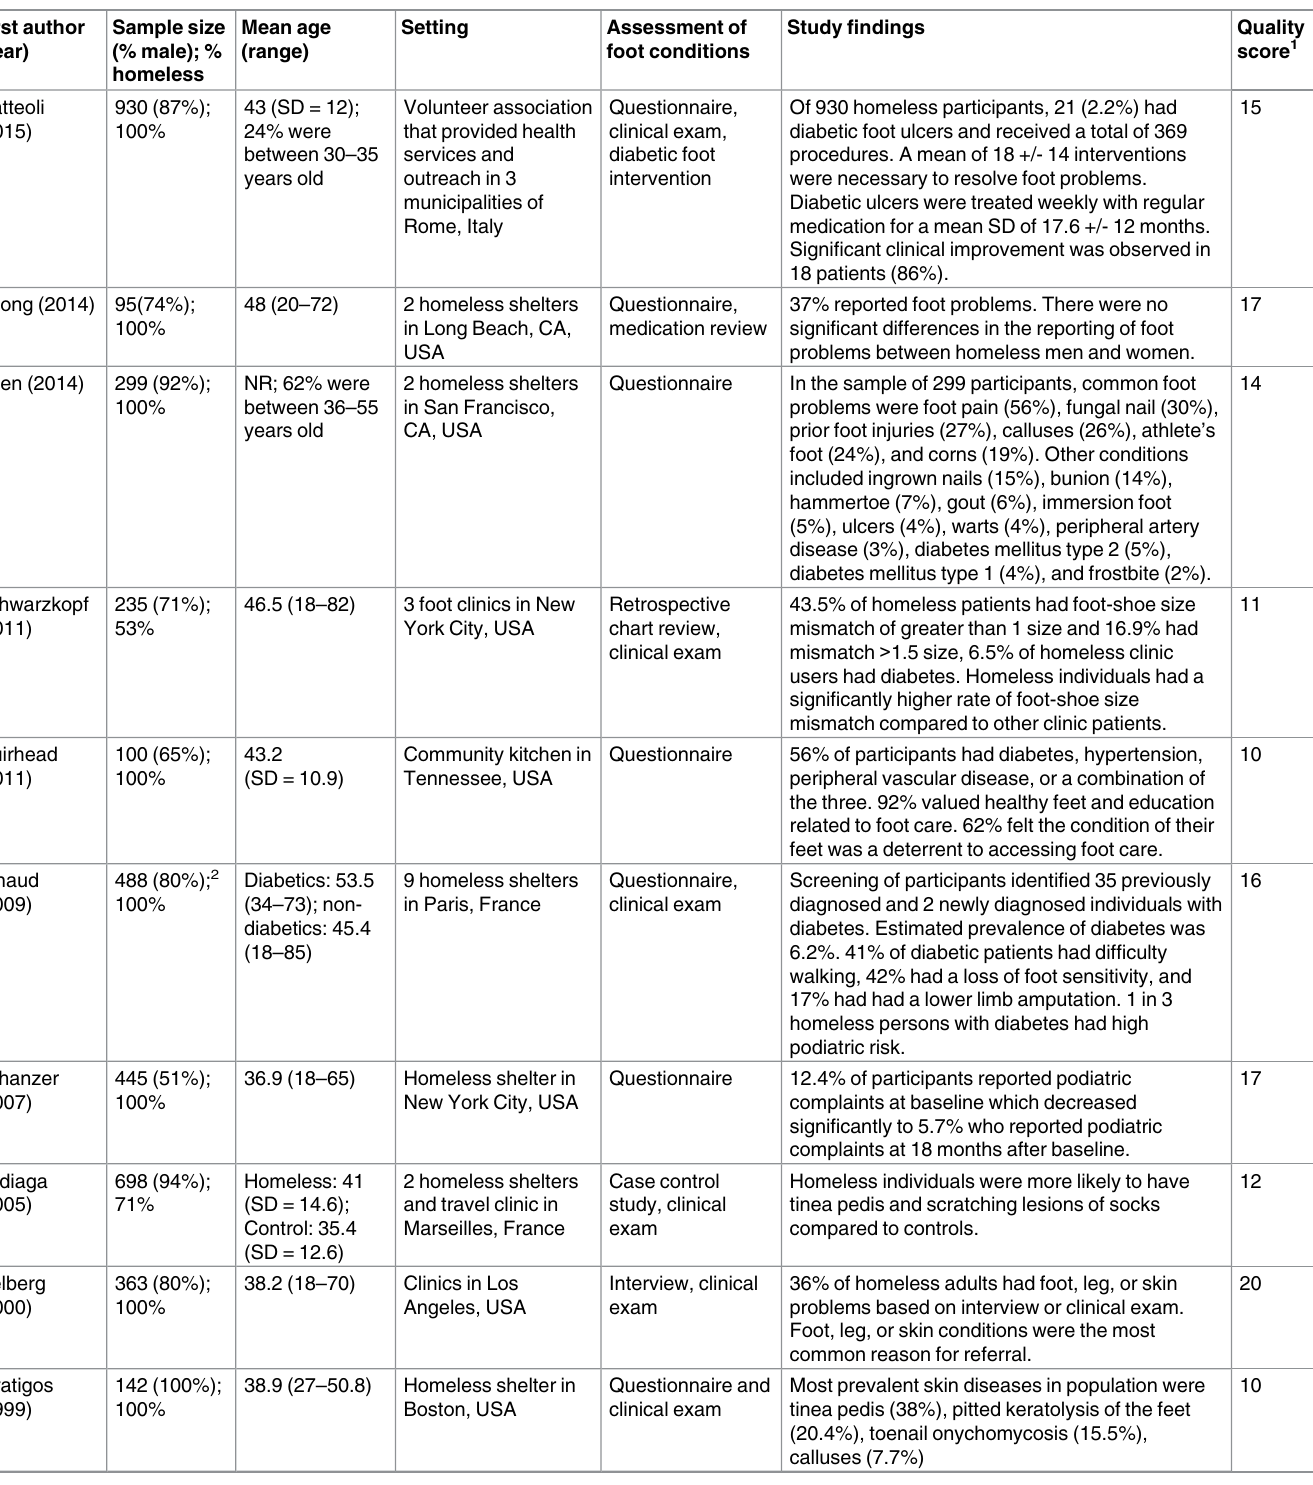
Table 1. Characteristics of 17 included